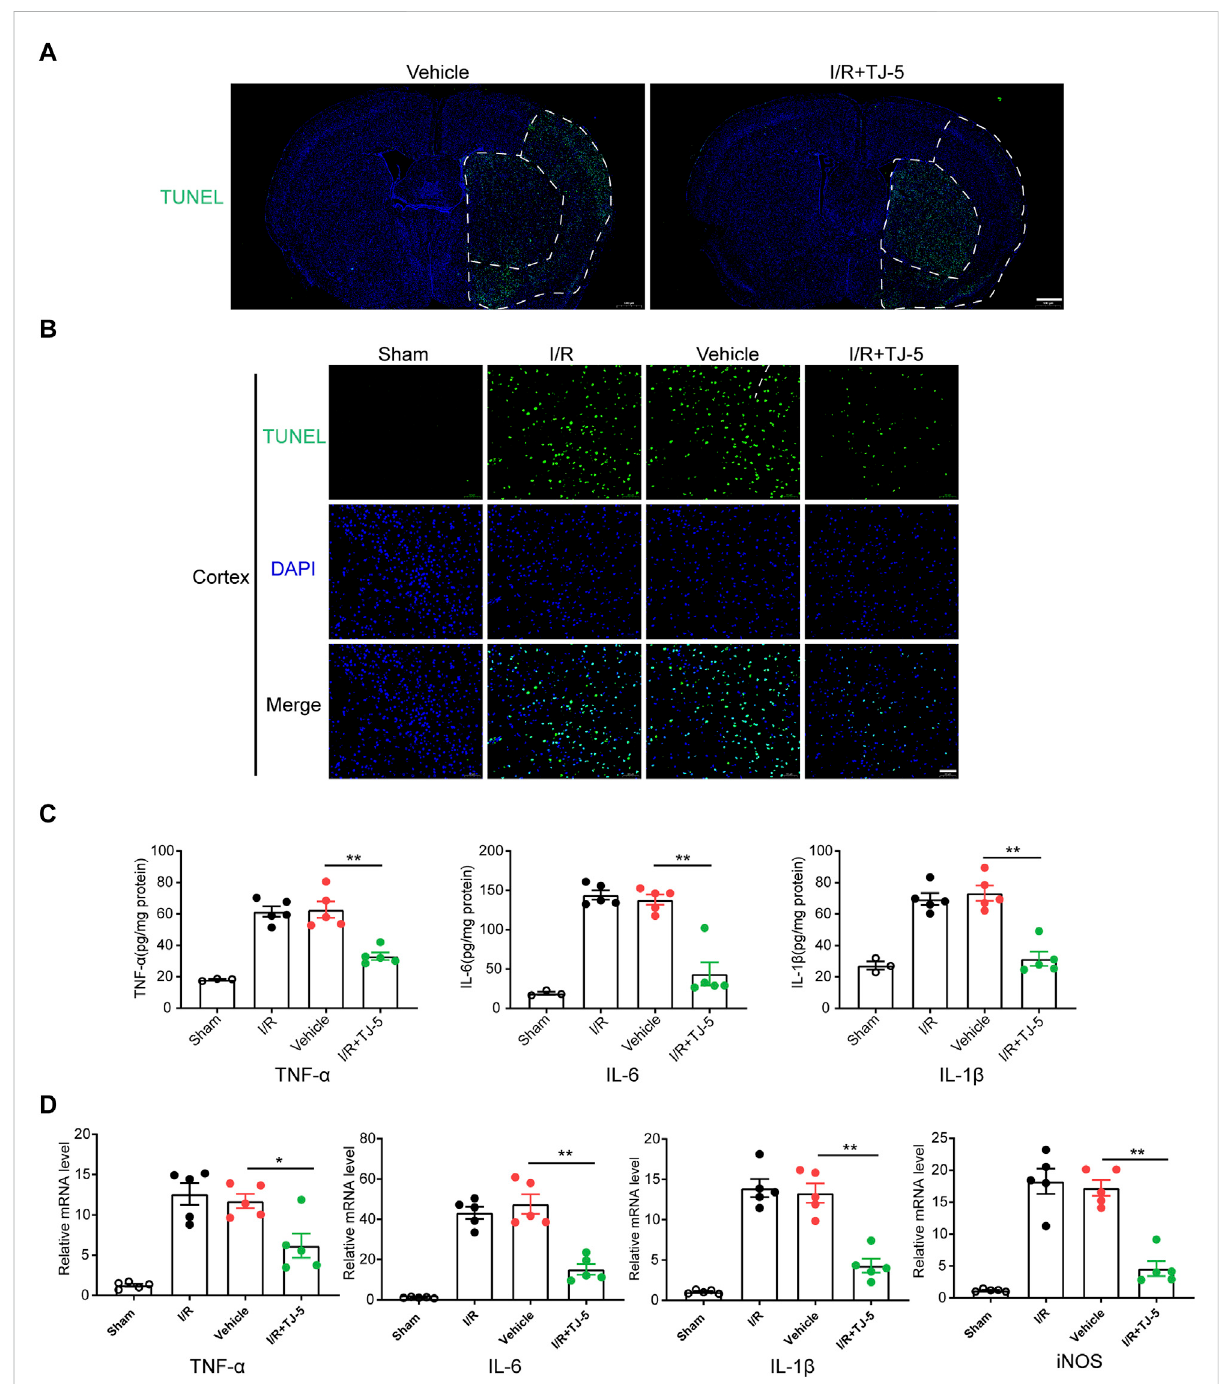
FIGURE 2 EffectofTJ-5treatmentontheneuroin fl ammatoryresponseandapoptosisinCIRImice.MicewereinjectedintravenouslywithTJ-5(15 mg/kg) after 1 h ischemia. (A) Representative TUNEL staining image of whole brain slices (scale bar = 500 μ m), white dashed line areas illustrate ischemic core (medial) and peri lesion (lateral) regions; the range of apoptosis in the brain was reduced with TJ-5. (B) Representative TUNEL staining image of cortex;thenumberofapoptoticcellswerereducedwithTJ-5treatment(scalebar=50 μ m). (C) TNF- α ,IL-6,IL-1 β ,andiNOSmRNAexpression levelsinthebrainweredownregulatedwithTJ-5treatment. (D) ThecontentofTNF- α ,IL-6,andIL-1 β inthebrainwerereducedwithTJ-5treatment. All the experiments were repeated three times. Values are mean ± SEM. (* p < 0.05, ** p <